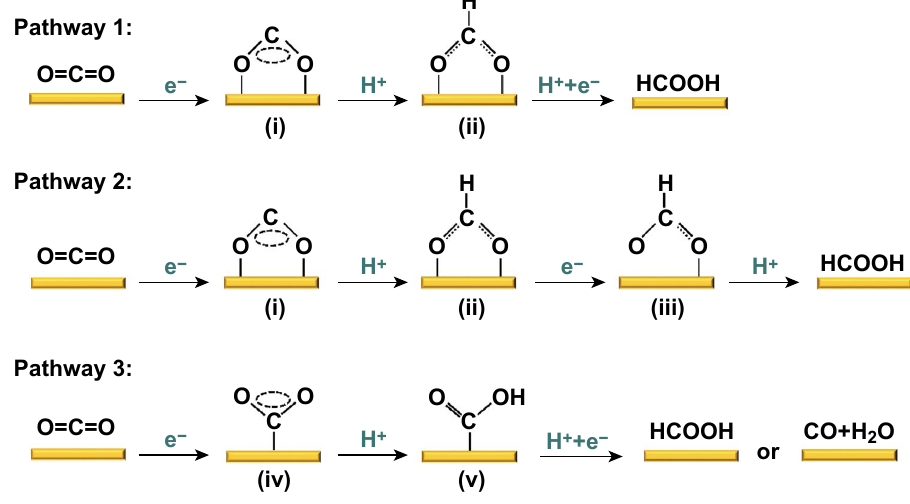
Fig. 1 Possible reaction pathways for electrocatalytic CO 2 ER on the Sn‑based catalysts in aqueous